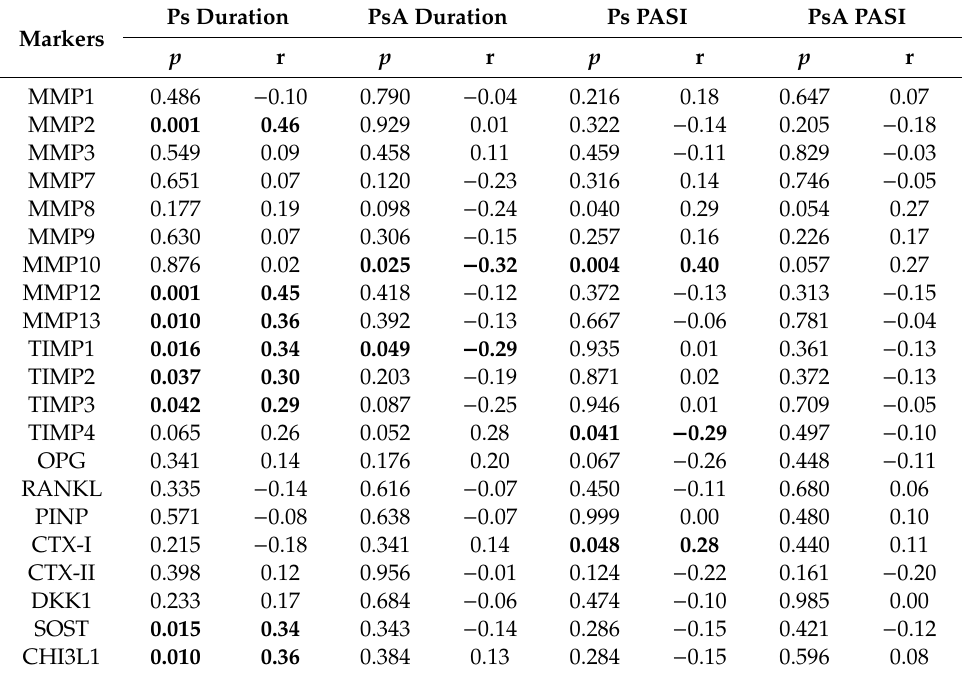
Table 3. Correlation analysis between osteoimmunological biomarker concentrations and duration of disease or PASI score. Correlations reaching statistical significance are given in